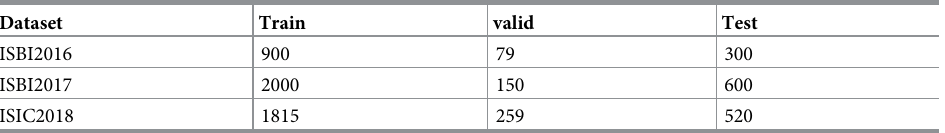
Table 2. The introduction of the public